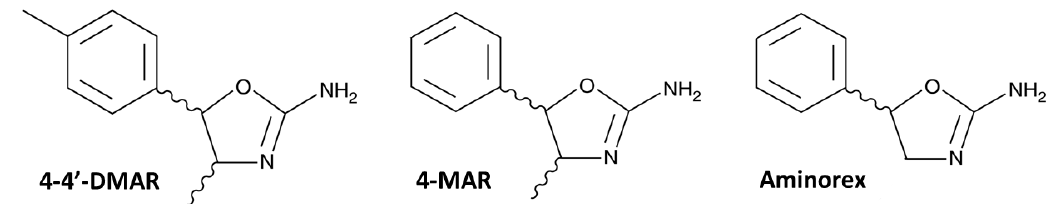
Figure 1. Structures of 4,4’-DMAR (4-Methyl-5-(4-methylphenyl)-4,5-dihydrooxazol-2-amine), 4-MAR (4-Methyl-5-phenyl-4,5-dihydrooxazol-2-amine) and Aminorex (5-phenyl-4,5-dihydro-1,3-oxazol-2-amine) copied from the Cayman Chemical website (https://www.caymanchem.com, accessed date 17 May 2021).